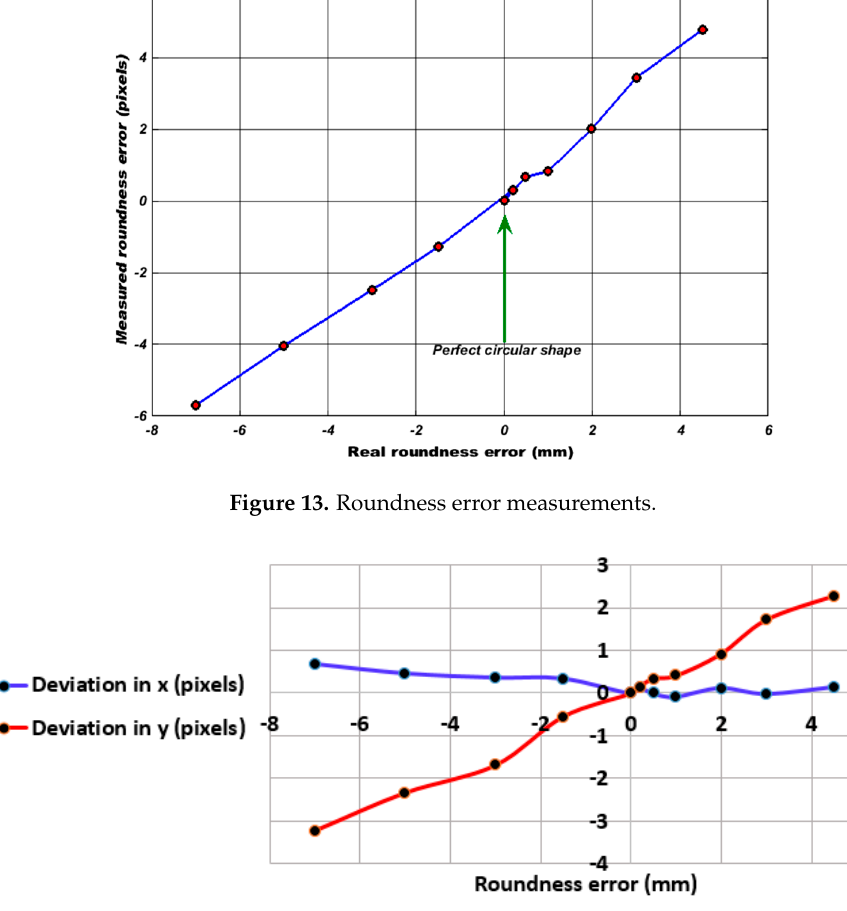
Figure 14. Roundness error versus the estimated measurement deviation. Table 5. List of estimated calibration errors for the two